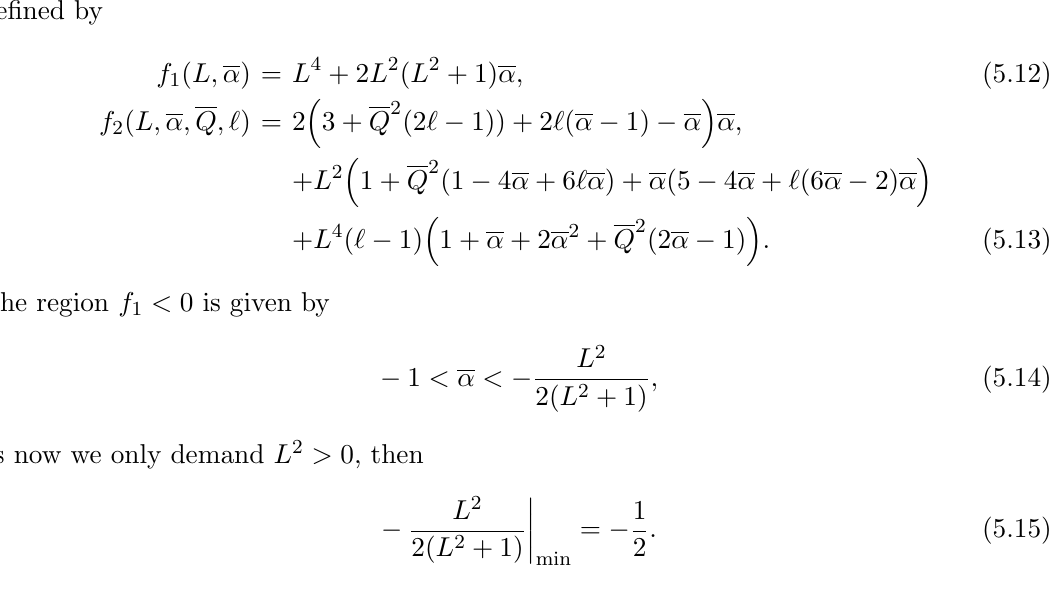
Figure 9 . The unstable regions of the de Sitter charged Gauss-Bonnet black hole for (cid:11) < (cid:0) 1 = 2. From the left to the right (cid:11) = (cid:0) 0 : 55 ; (cid:0) 0 : 7 ; (cid:0) 0 : 8 and (cid:0) 0 : 9, respectively, where the light yellow region corresponds to f 1 < 0 and the light red region plus the light blue region correspond to f 2 < 0. As in (cid:12)gure 8, the light red region corresponds to ‘ = 3 and the light red region plus the light blue region correspond to ‘ =